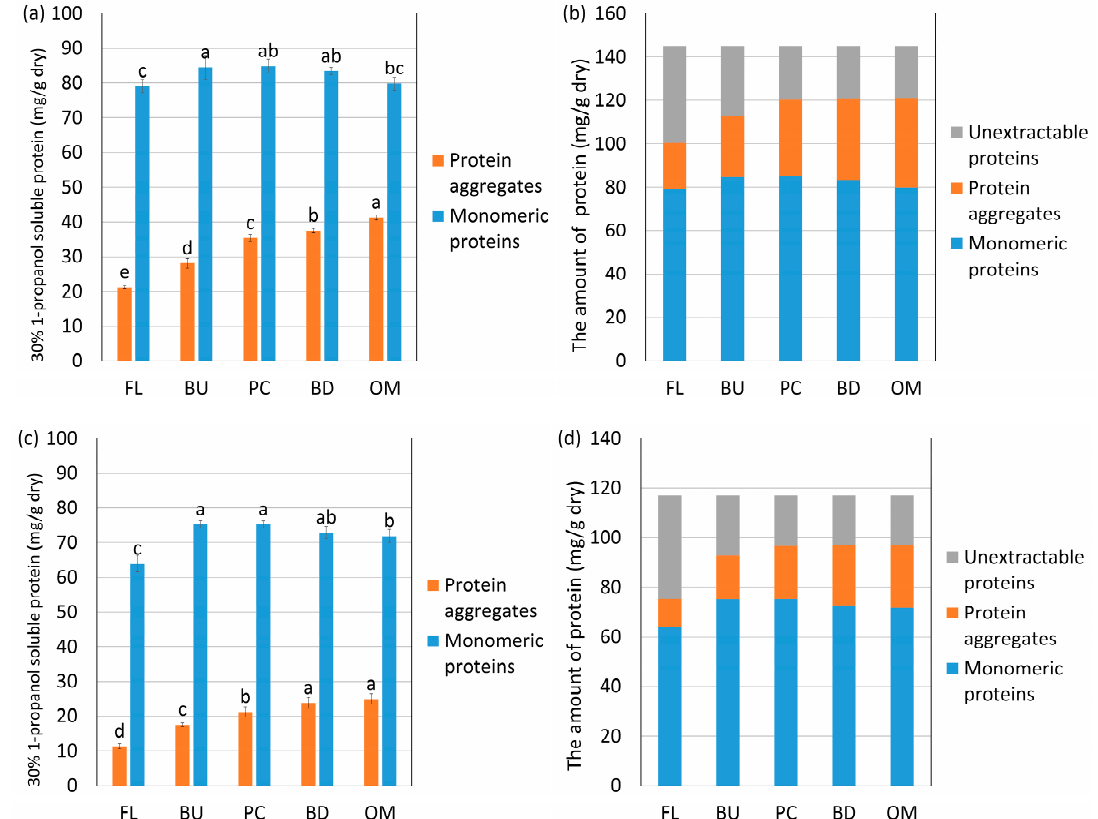
Figure 4. Changes in the amount of protein aggregates, monomeric proteins extracted with 30% 1-propanol, and unextractable proteins during mixing from high-protein flour (HF) ( a , b ) and low-protein flour (LF) ( c , d ). FL, BU, PC, BD, and OM indicate flour (before mixing), buildup, peak consistency, breakdown, and overmixing, respectively. Protein aggregates mean “A”, and monomeric proteins mean “B” in Figure 2. Unextractable proteins mean proteins not extracted with 30% 1-propanol. The error bars show standard deviations ( n = 6). Different letters on the graph indicate significant differences ( p < 0.05).